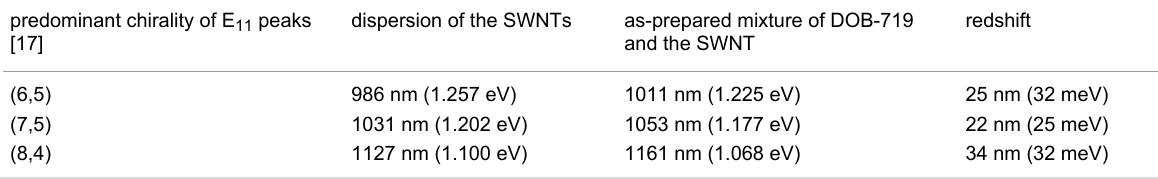
Table 2: Peaks of absorption (E 11 ) for the neat SWNT dispersions and the as prepared mixtures of DOB-719 with the SWNT, redshifts of E 11 in absorption due to an admixture of the dye. predominant chirality of E 11 peaks